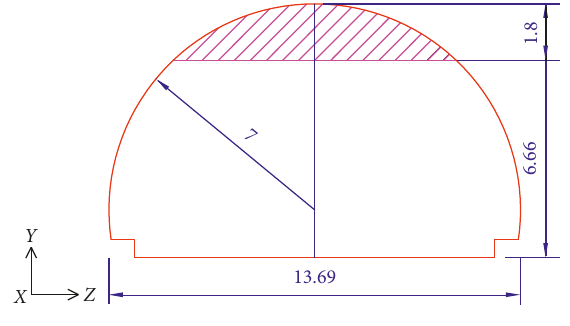
Figure 1: Cross section of the